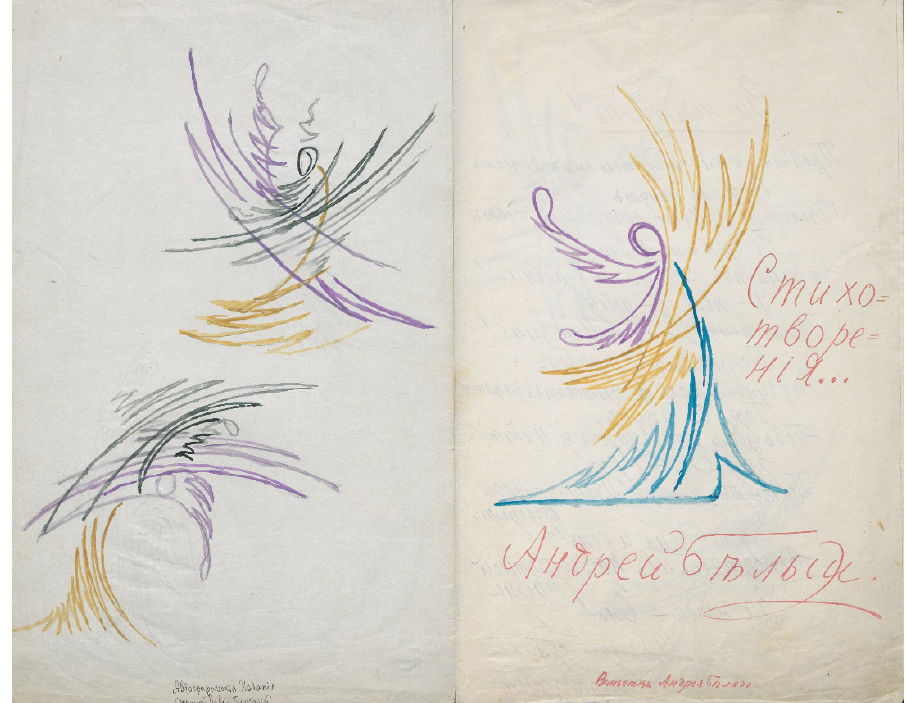
Figure 15. Andrei Bely. Poems… Handwritten book. 1918–1922. RGALI.